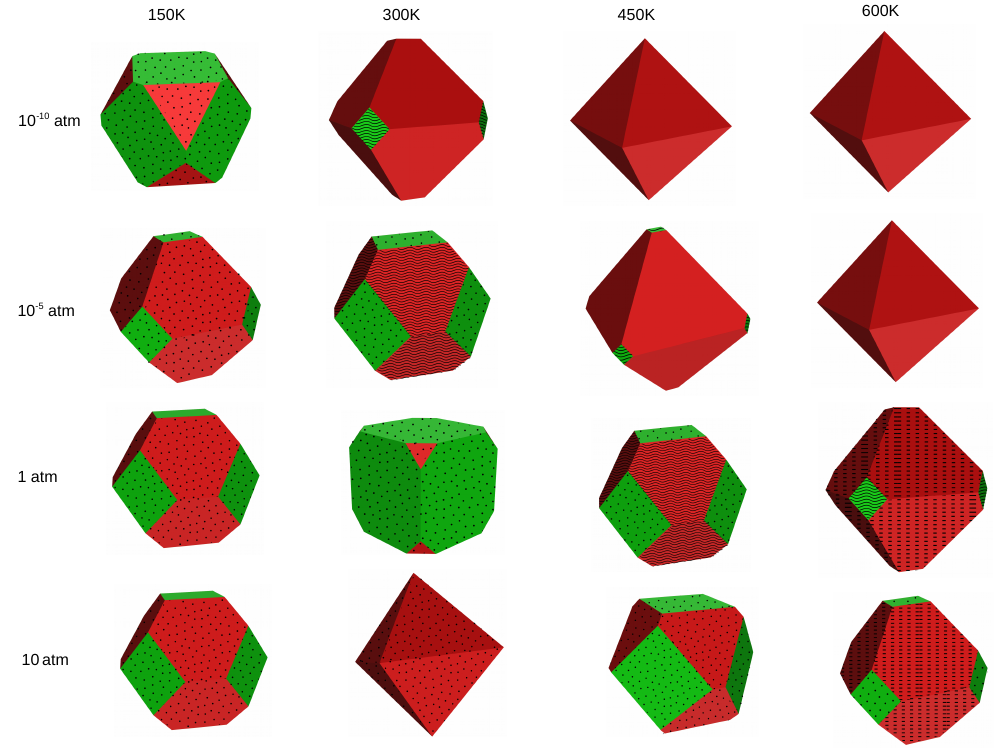
Figure 5. The effect of temperature on the morphology and composition of the BaF 2 crystal at four pressure conditions—surface (111) in red and (100) in green. The clean surfaces are indicated by empty planes, the dotted planes correspond to 100% HF coverage, wavy lines to 50% HF coverage and dashed planes to 25% HF